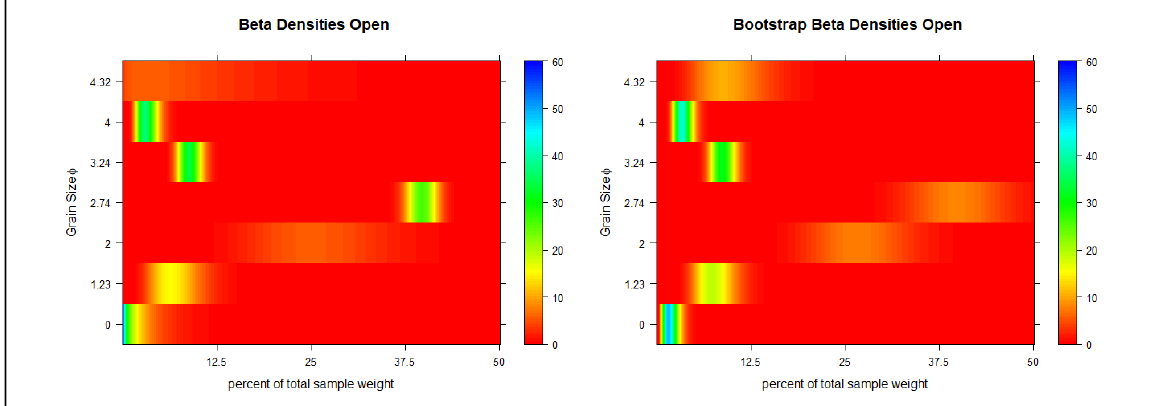
Figure 11. Box plot of proportion of sediment weights for different grain sizes. Control